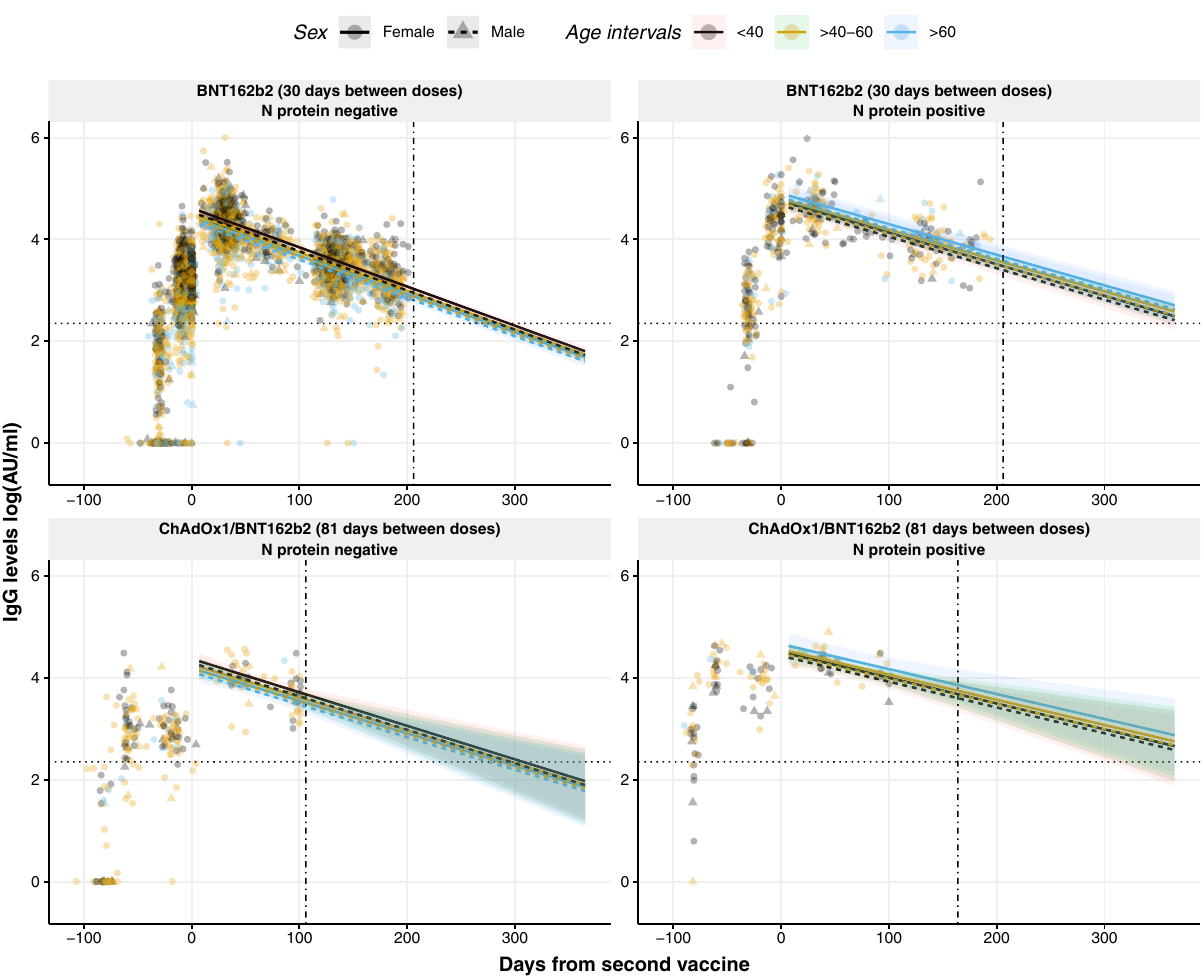
Fig. 2 Dynamics and projection of circulating IgG levels against RBD after the second dose of the COVID-19 vaccination using a linear model. Distribution of IgG levels, represented in log(AU/ml), over time (days from the second vaccine) in individuals with no prior infection vaccinated with BNT162b2 (top left) or with the combination ChAdOx1/BNT162b2 (bottom left), and in individuals previously infected and vaccinated with BNT162b2 (top right) or with the combination ChAdOx1/BNT162b2 (bottom right). Circles and triangles represent the observed levels of circulating IgG antibodies in females and males, respectively. Solid and dashed lines represent the predicted levels of circulating IgG antibodies calculated by the model in females and males, respectively. Black, yellow, and blue colors represent individuals with age <40, 40 – 60, and >60 years, respectively. Horizontal black dotted line represents the threshold for assay positivity. Vertical dash-dotted line indicates where the out-of-sample trend starts. Shadowed areas represent the 95% con fi dence interval. Center for the con fi dence interval is the predicted